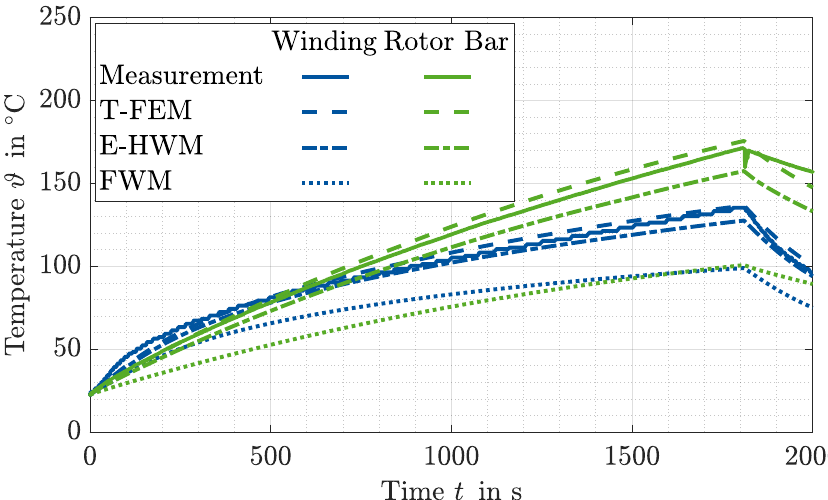
Figure 11. Simulated and measured stator winding and rotor bar temperature of the exemplary IM using the T-FEM, the E-HWM, and